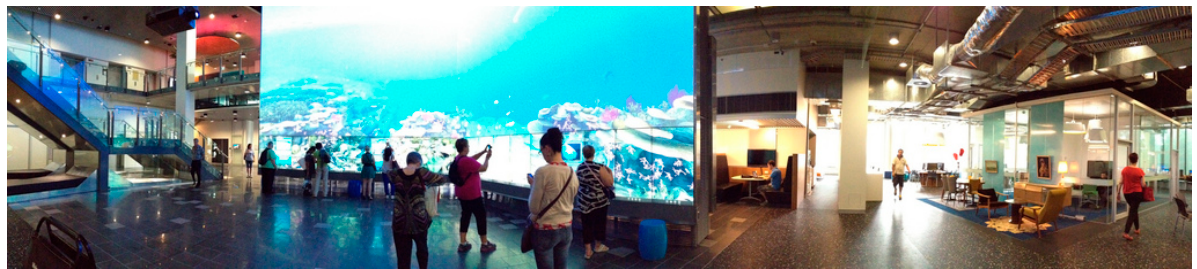
Figure 1. QUT’s Cube